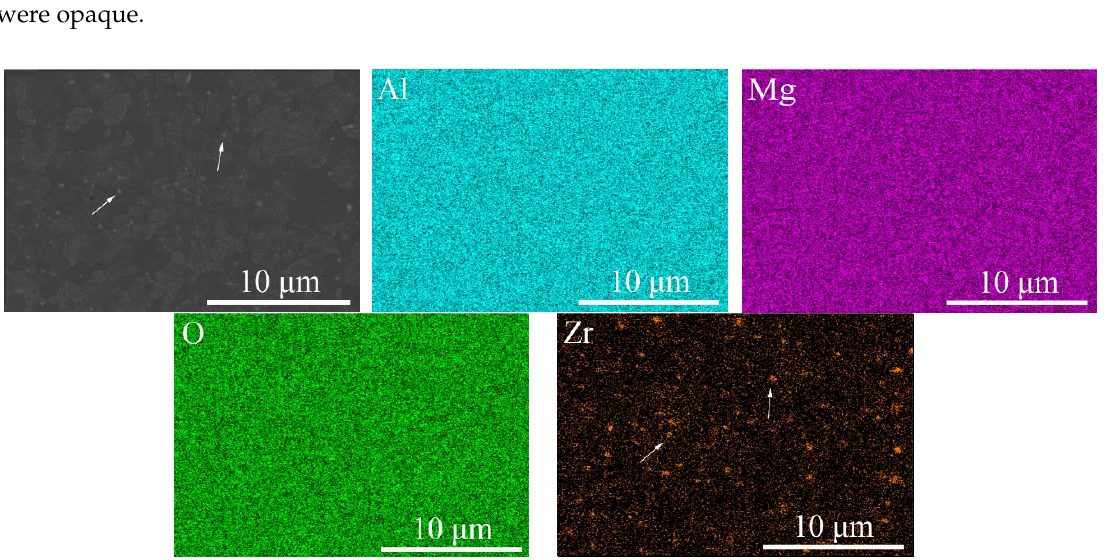
Figure 5. SEM/EDS mapping analysis of opaque sample E.